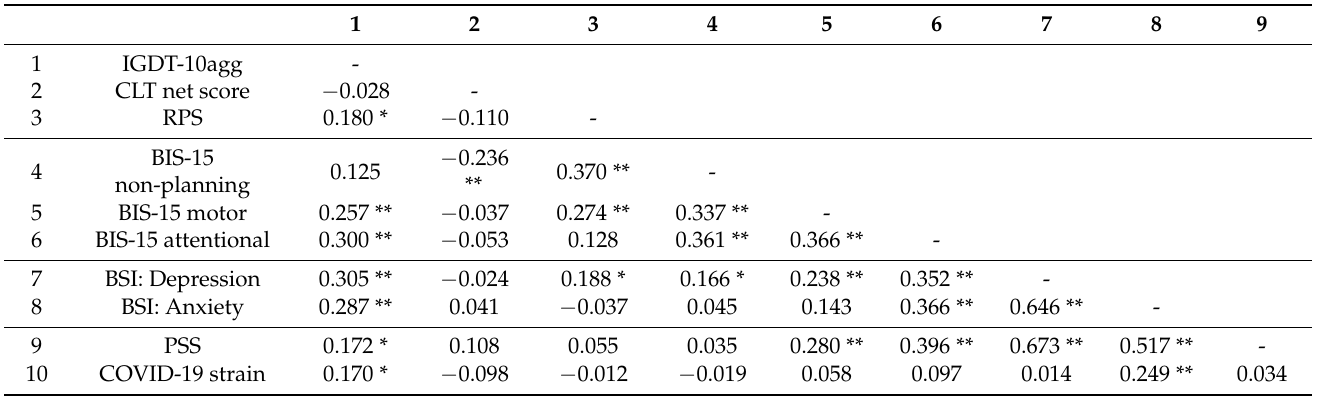
Table 2. Coefficients of the correlations with symptoms of a specific Internet-use disorder (IGDT- 10agg) within the “sIUD tendency”